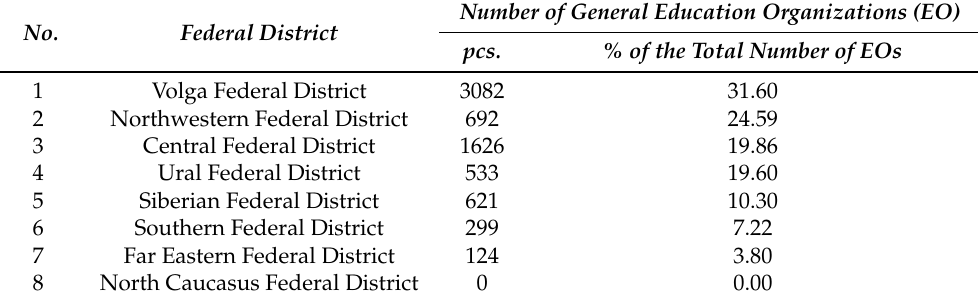
Table 1. The number of educational institutions using systems of automated cashless payments for meals in federal districts of the Russian Federation.